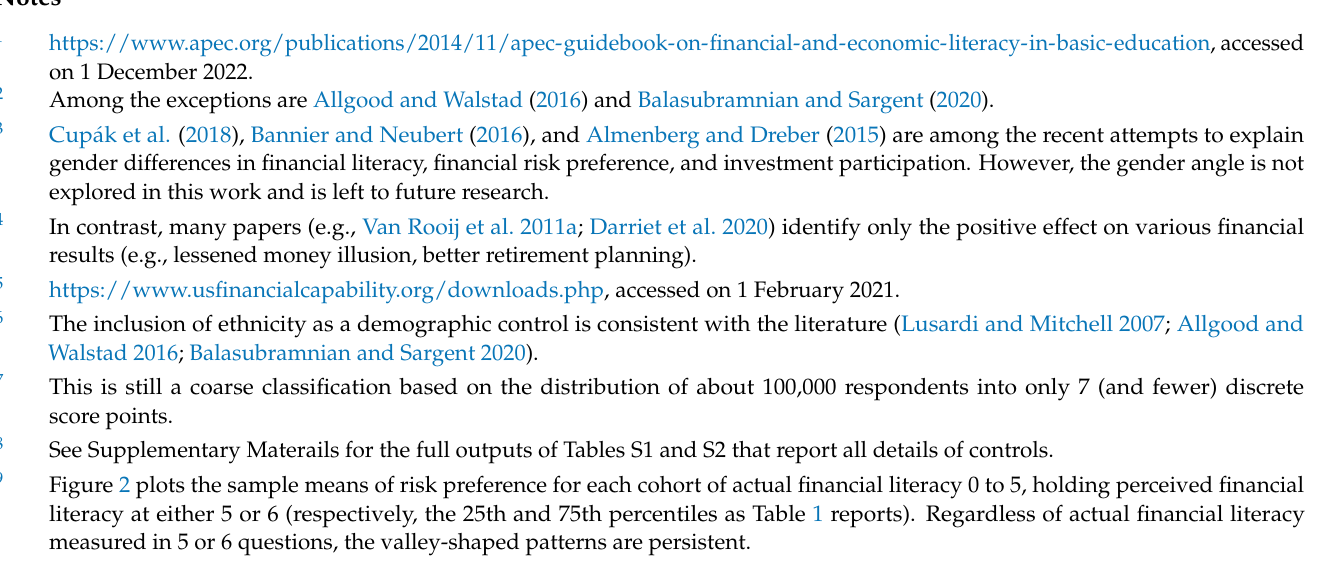
Response to question ‘When thinking of your financial investments, Risk preference